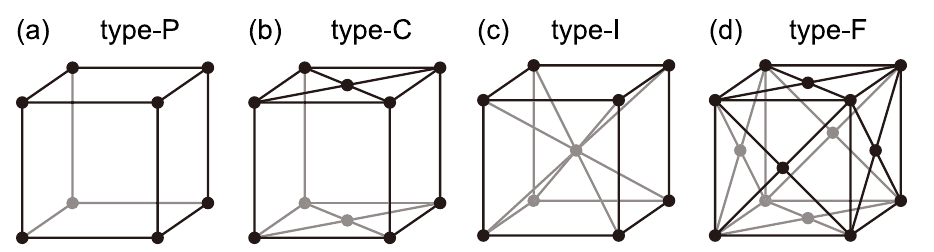
Fig 2. Basic cubic lattices. (a) Primitive (type-P) lattice. (b) Base-centered (type-C) lattice. (c) Body-centered (type-I) lattice. (d) Face-centered (type-F) lattice.